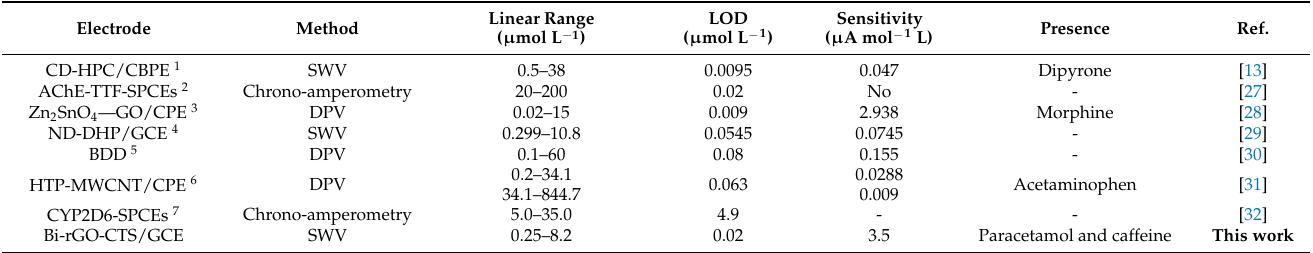
Table 1. Comparison of analytical parameters in the determination of 3-methylmorphine on different modified